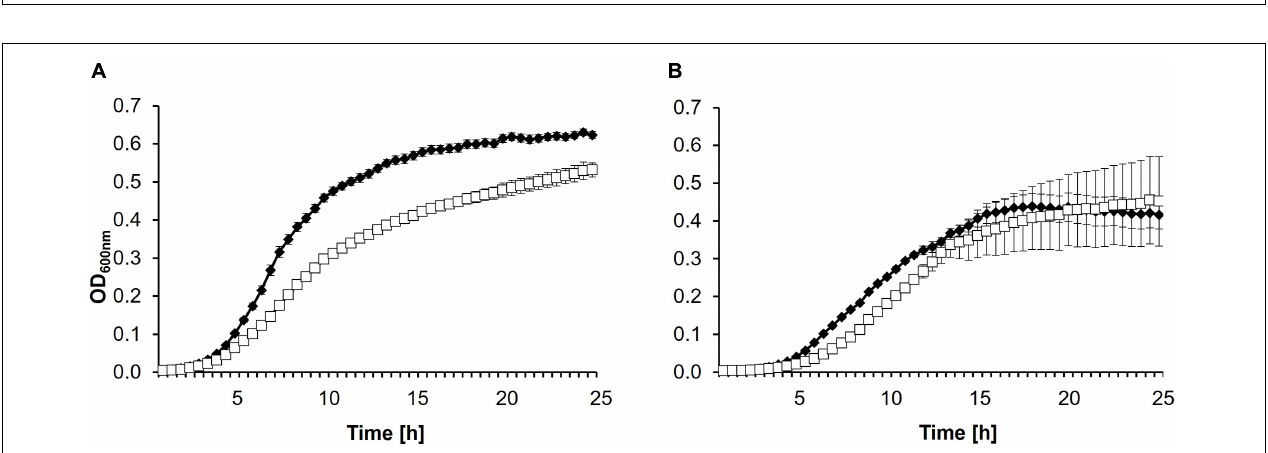
Frontiers in Microbiology |